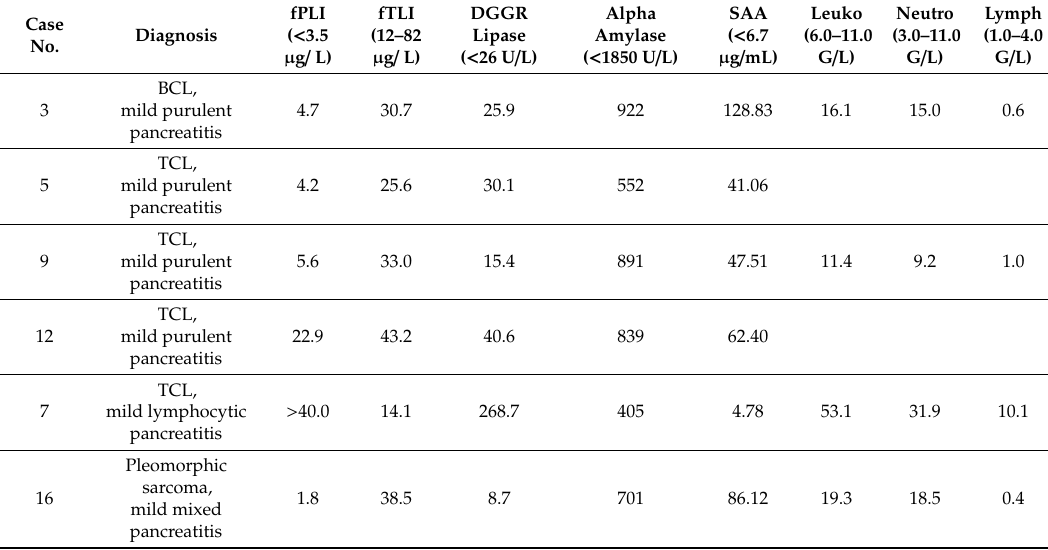
Table 3. Clinical pathology data of cats with non-epithelial pancreatic tumors (n = 6). Case